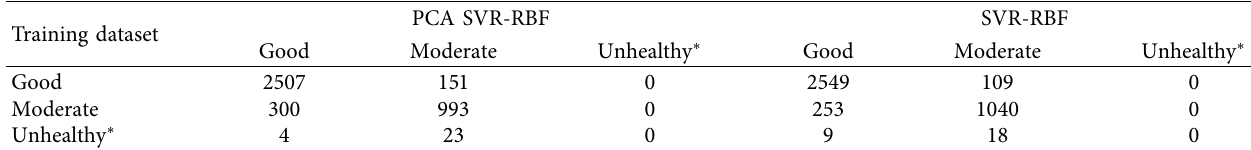
Table 12: Confusion matrix for the AQI classifications obtained with both models for the training set.